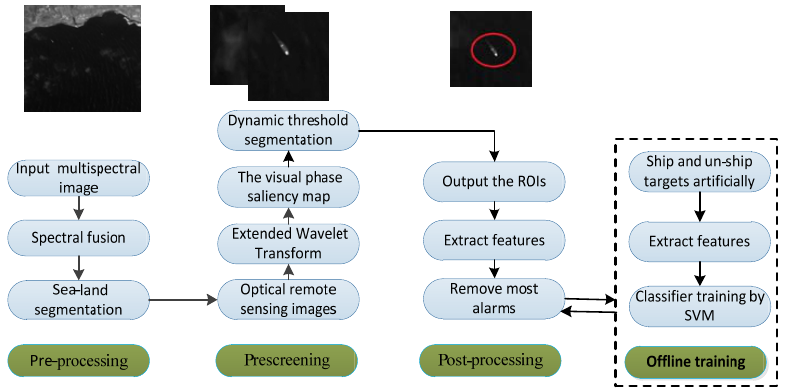
Figure 1. Flowchart of our proposed detection algorithm.